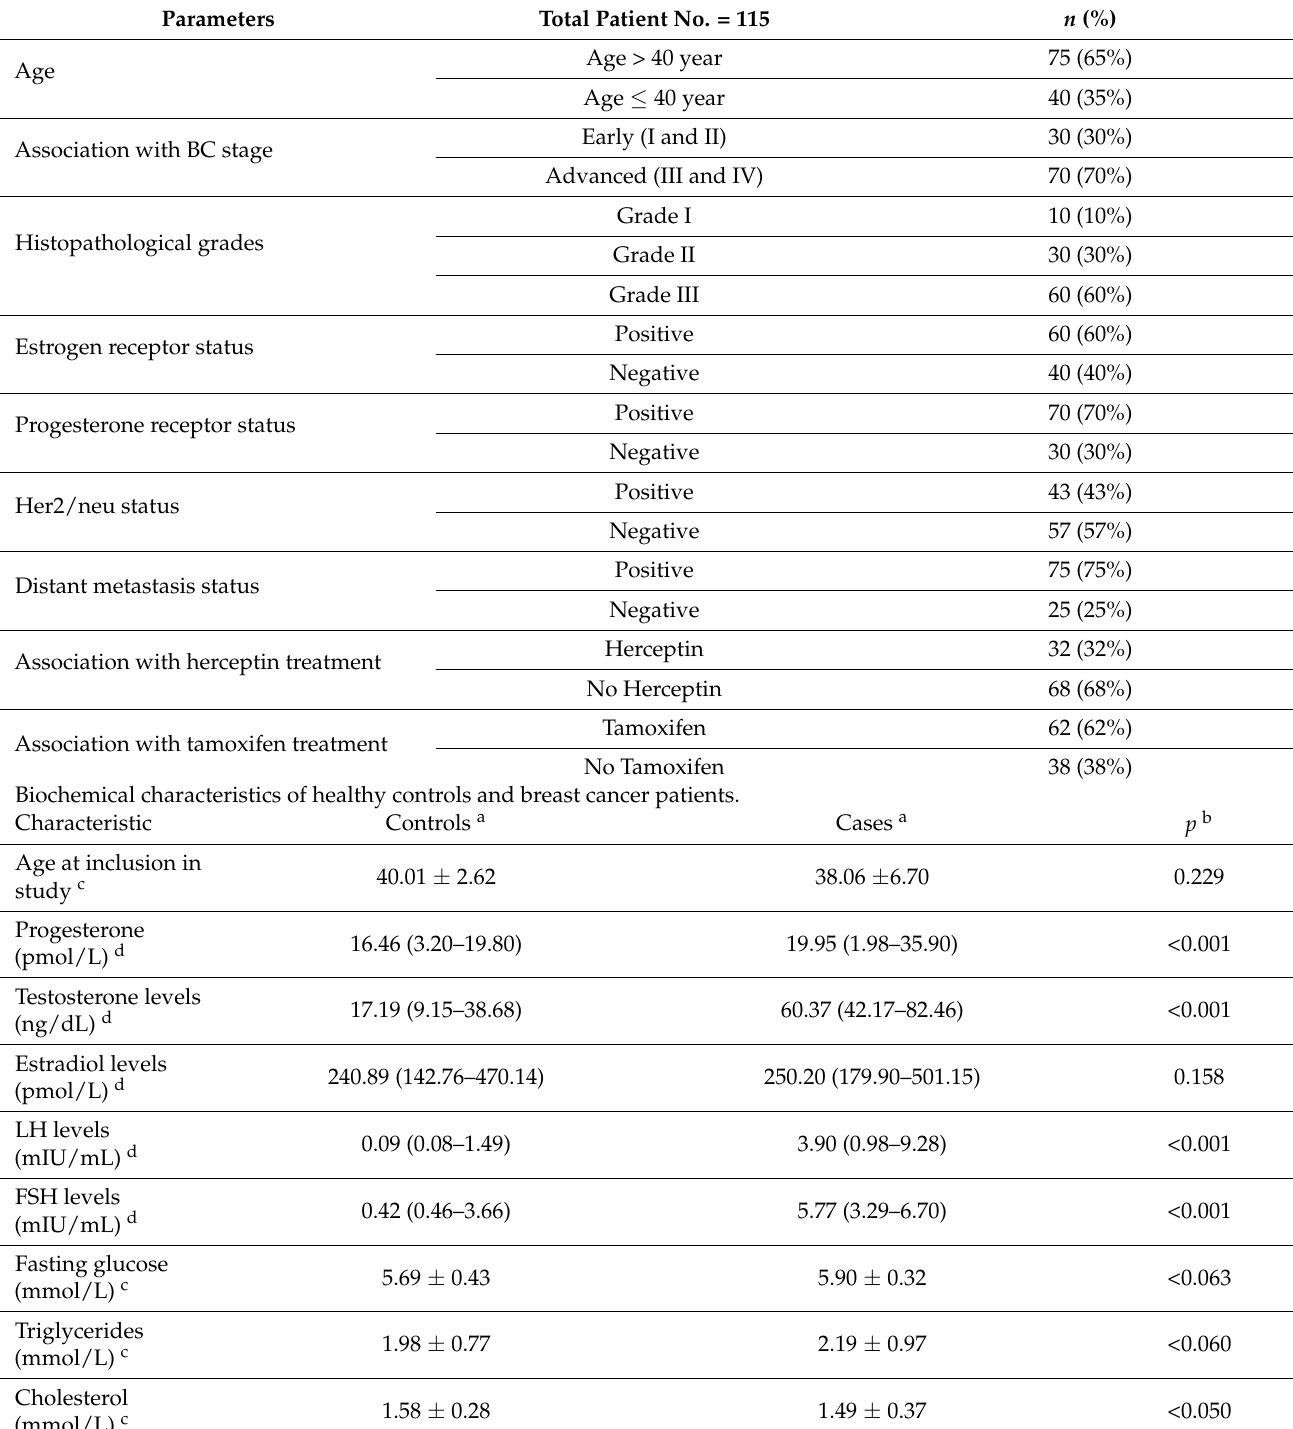
Table 2. Baseline clinicopathological characteristics of BC